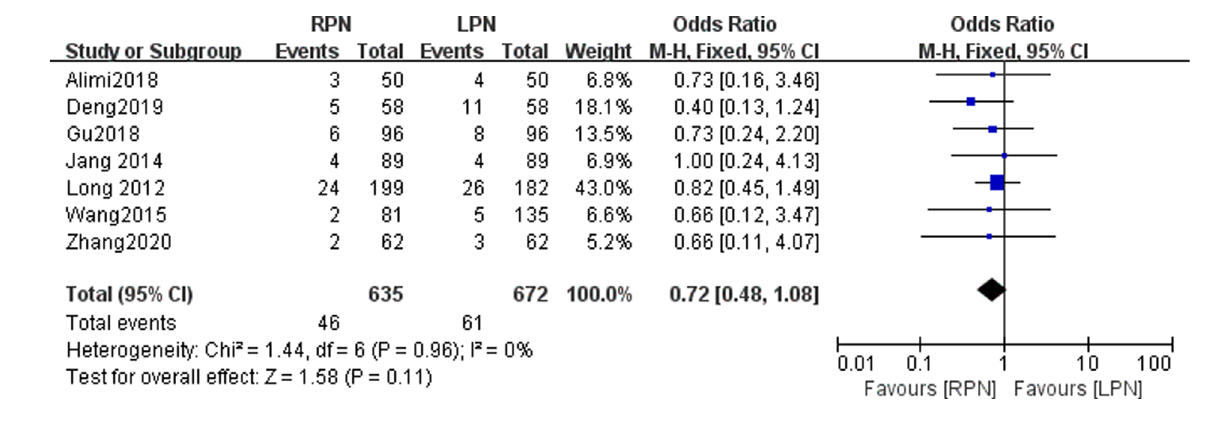
FIGURE 5 Forest plot for transfusion between the RPN and LPN.